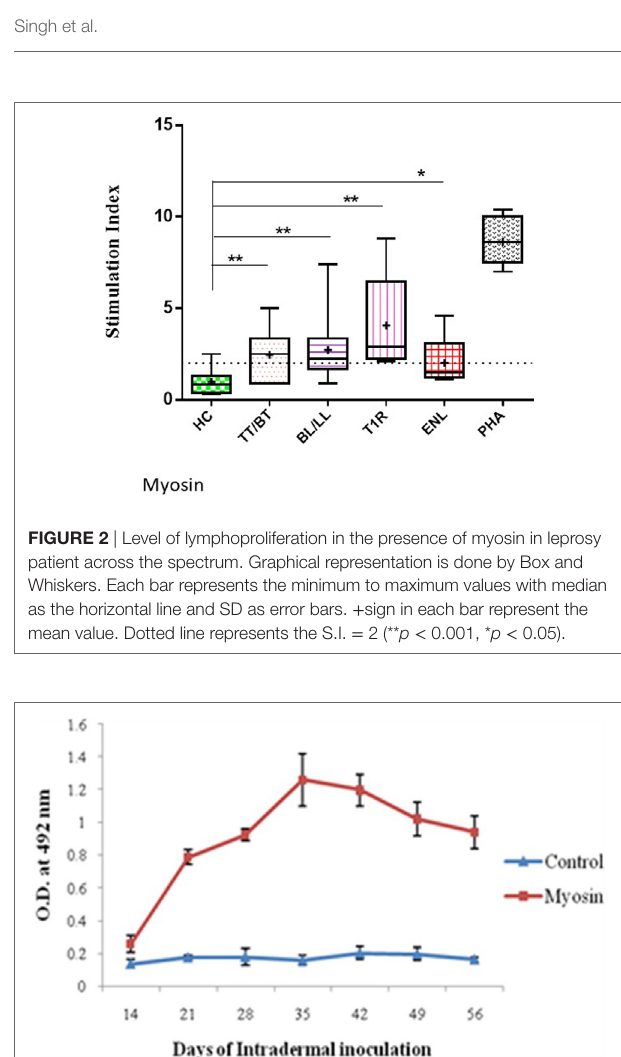
FigUre 3 | Levels of antibodies against myosin in Mycobacterium leprae soluble antigen-hyperimmunized rabbit sera at different time intervals. Each dot with error bar represents the mean OD value with SD at different time intervals.